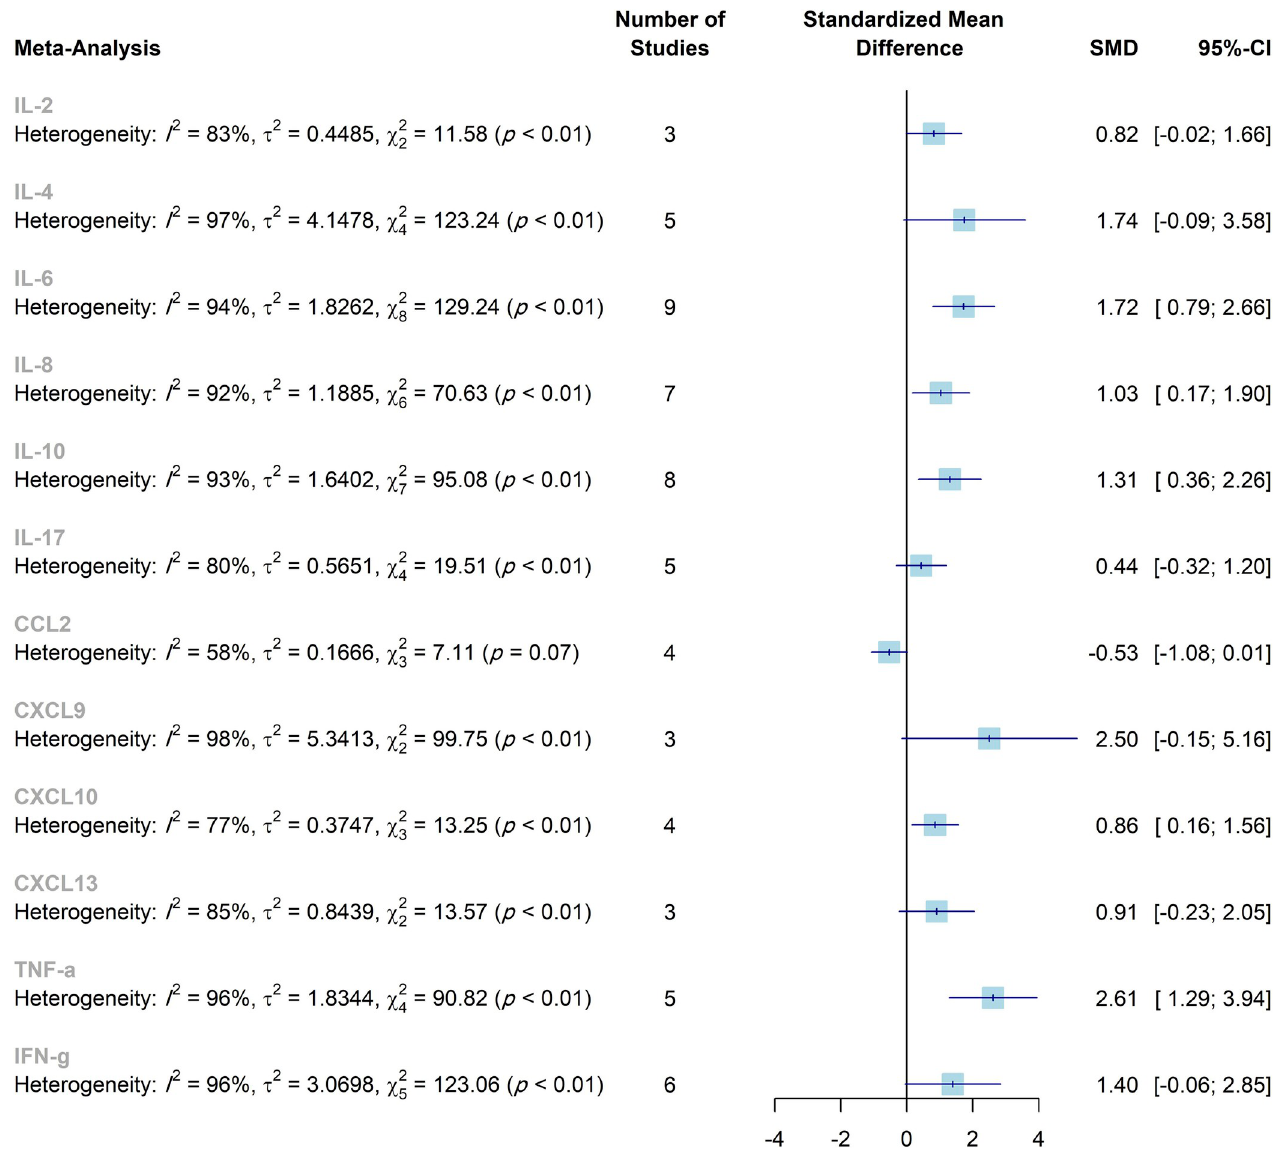
Fig 7. Summary of the overall effects and heterogeneity of the concentration of the cytokines in the CSF. SMD, standardized mean difference; CI, confidence interval.